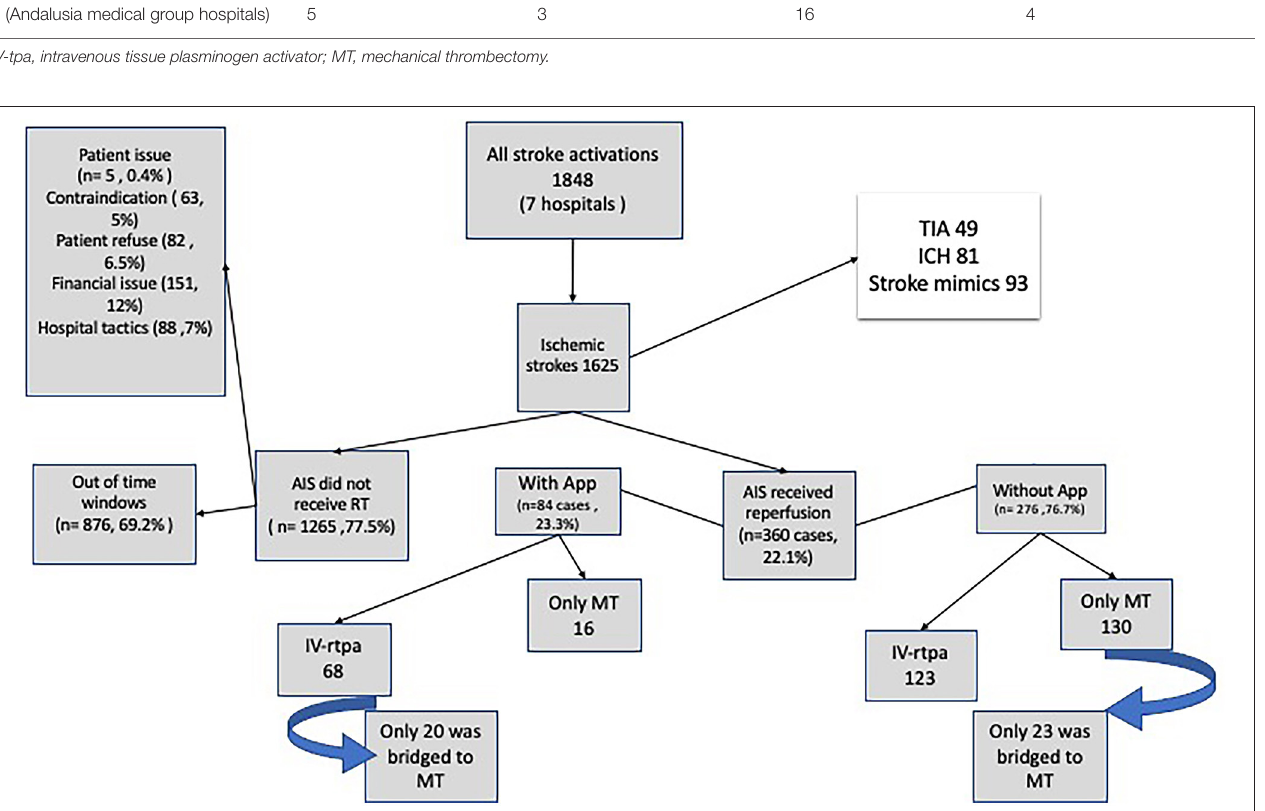
time) were significantly shorter among the patients who